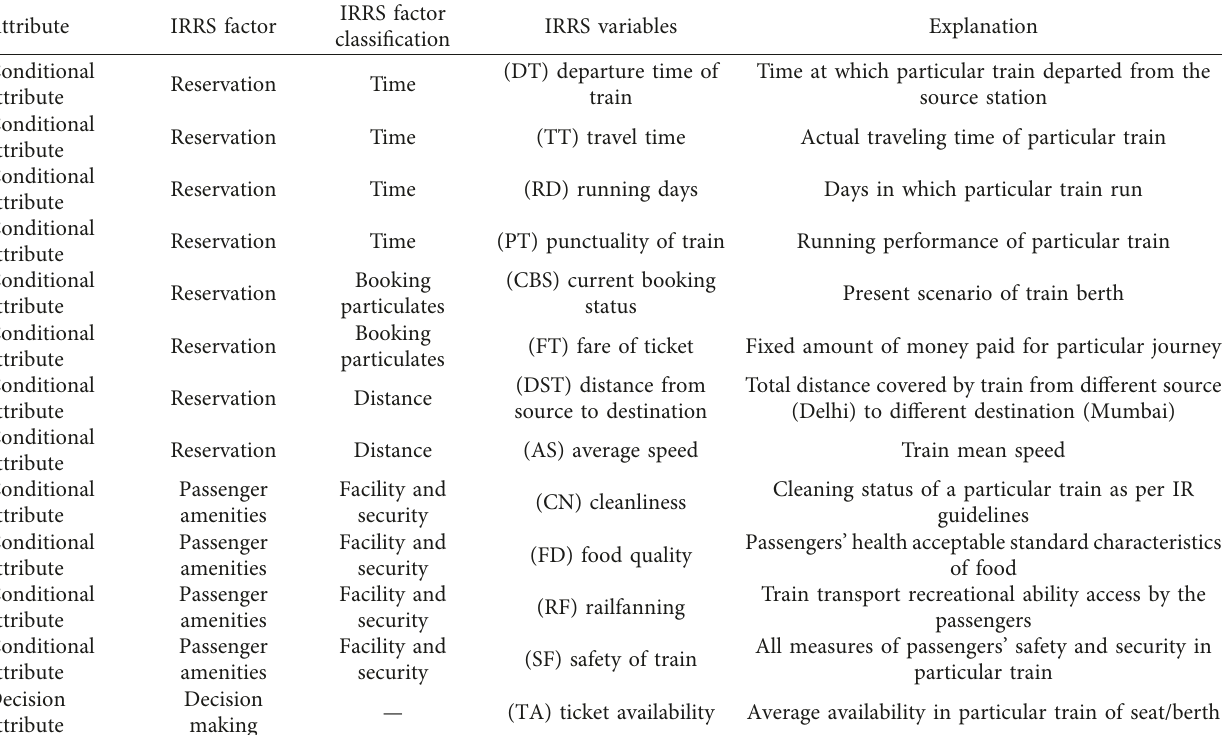
Table 2: Ticket availability issue collaborated with the listed IRRS factors associated with certain IRRS variables.